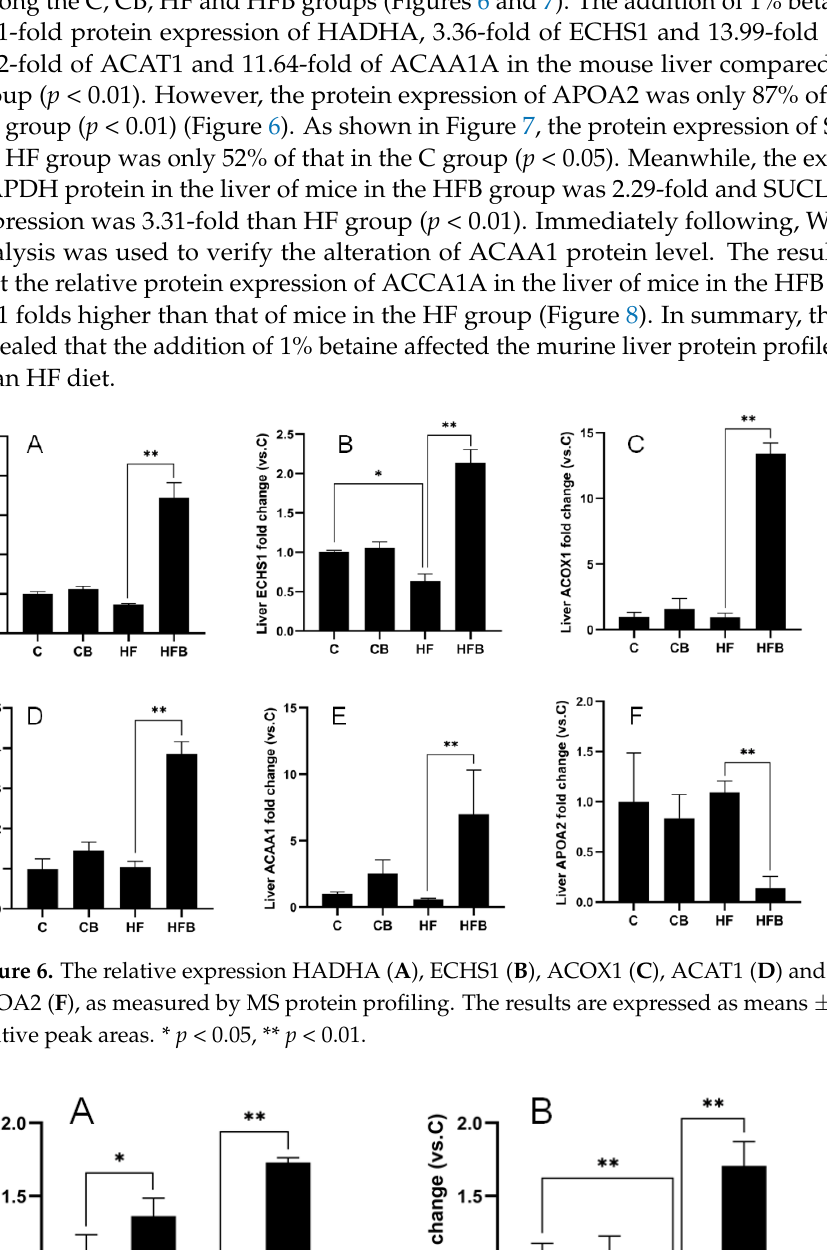
Figure 5. The signaling pathway of betaine affecting the liver protein profile of mice on an HF diet analyzed by the STRING database. Green lines: curated databases, purple lines: experimentally de- termined, yellow lines: textmining.